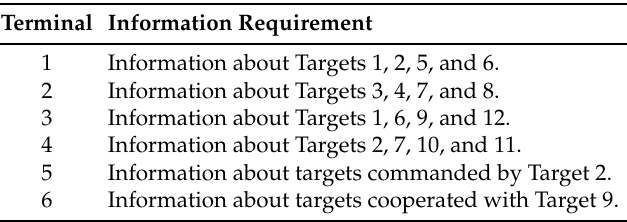
Table 4. Information requirements of different